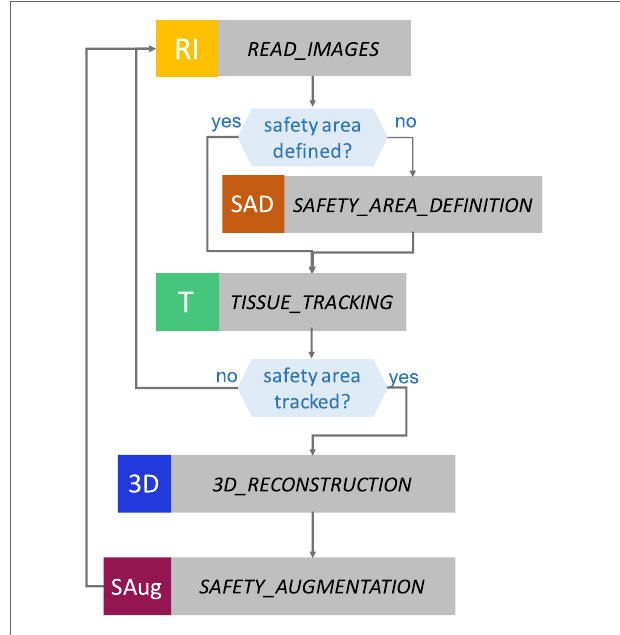
FigUre 4 | states of the enVisors framework . From top to bottom: in READ IMAGES , the images are captured from the stereo endoscope; in SAFETY AREA DEFINITION , the surgeon can select the safety area to be preserved from injuries; in TISSUE TRACKING , the area is tracked; in 3D RECONSTRUCTION , a dense reconstruction of the tissue surface is computed; and in SAFETY AUGMENTATION , the augmented reality image is